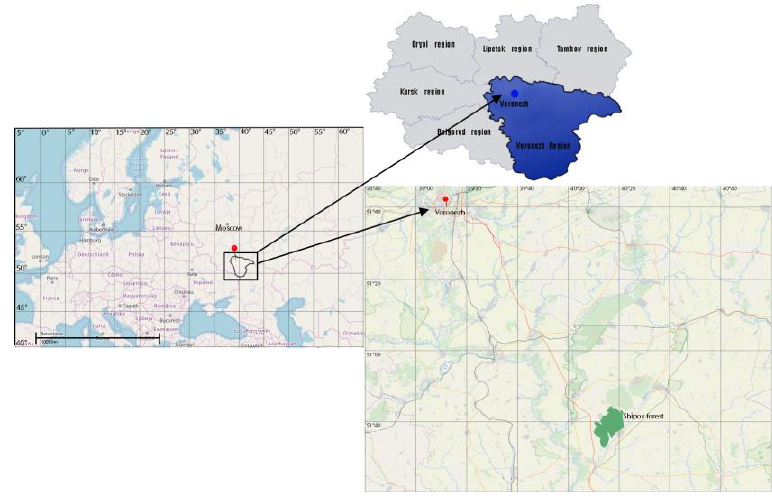
Figure 1. Study area: Shipov Forest, Voronezh Region, Central Federal District, Russia.